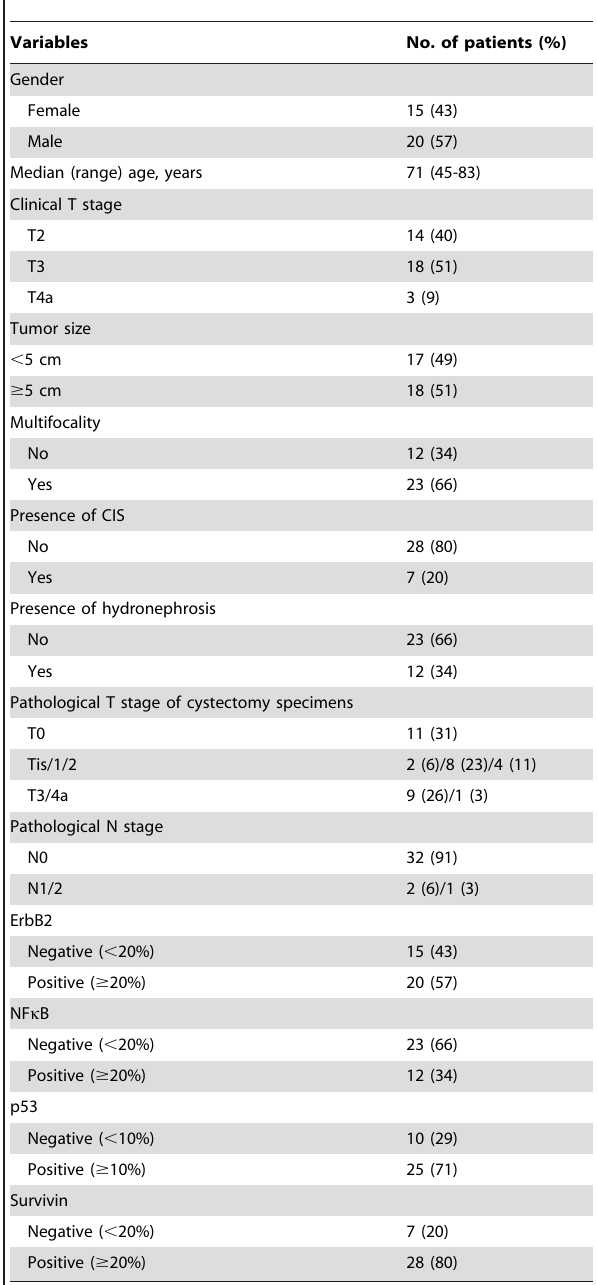
Table 1. Baseline statistics of the 35 MIBC patients who underwent induction CRT followed by cystectomy.